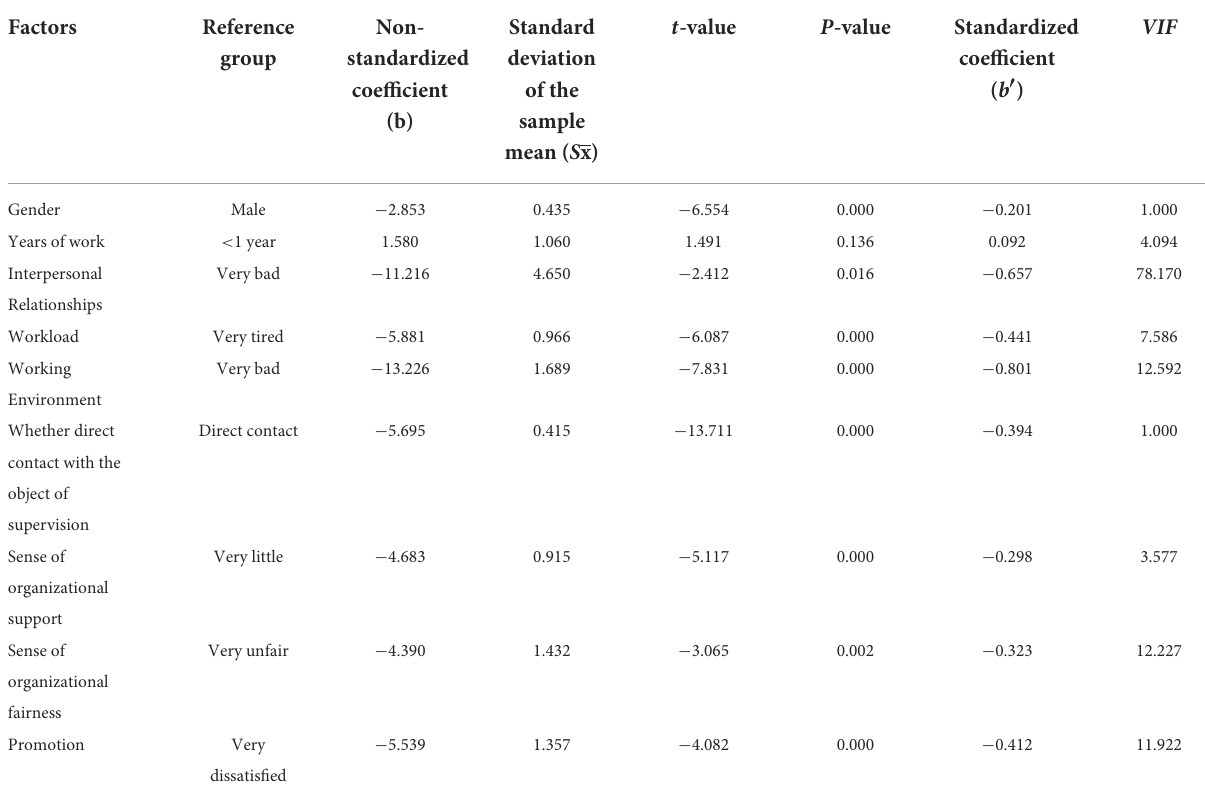
TABLE 8 Multiple linear regression analysis of specific factors influencing burnout among prison